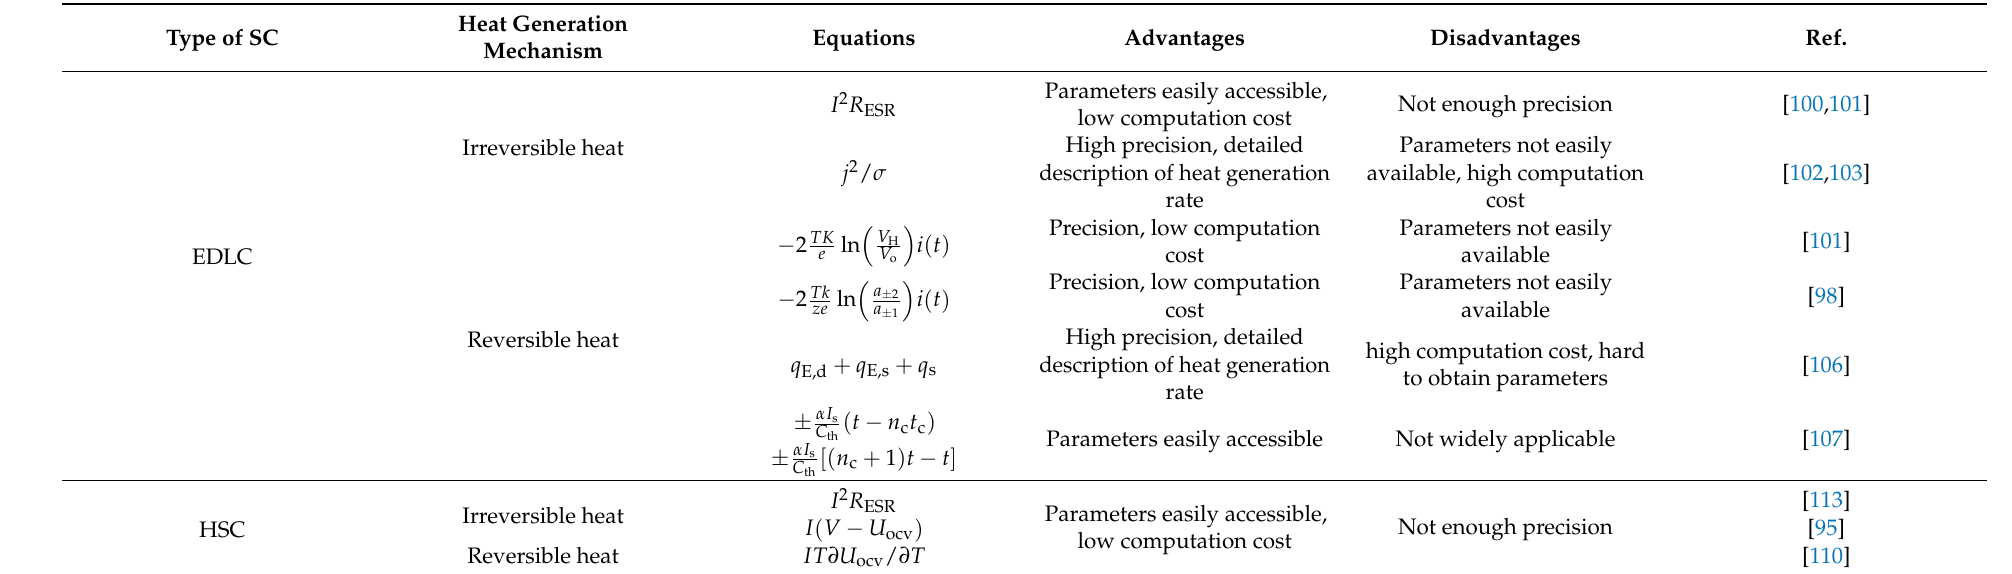
Table 3. Summary of thermal model equations for